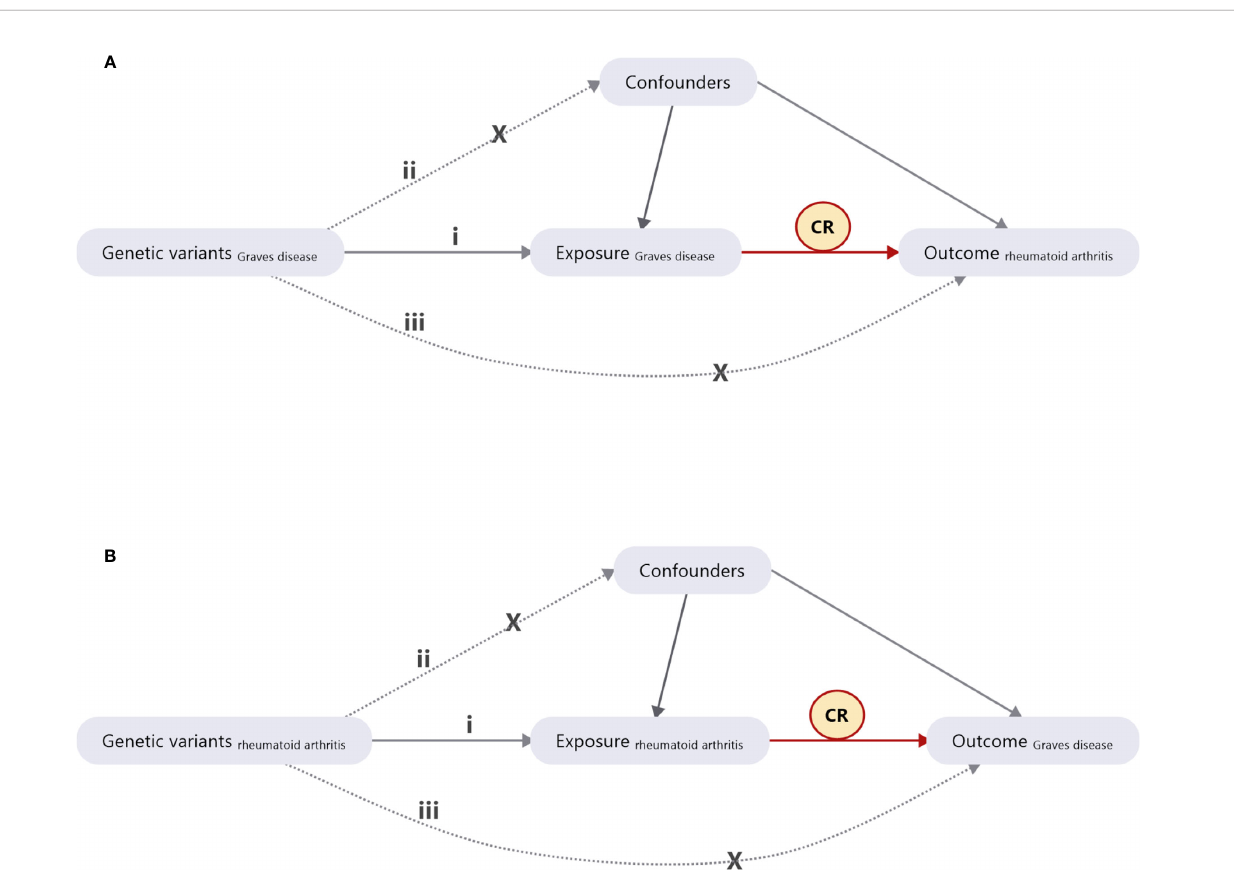
FIGURE 1 | Diagram of Mendelian randomization (MR) study design. (A) The causal estimation of Graves ’ disease (GD) on rheumatoid arthritis (RA). (B) The causal estimation of RA on GD. i) The genetic variants selected as instrumental variables (IVs) should be strongly associated with the risk factor of interest. ii) The genetic variants used as IVs should not be associated with any confounders. iii) The IVs should affect the risk of the outcome merely through the risk factor, not via any alternative pathways. CR, causal